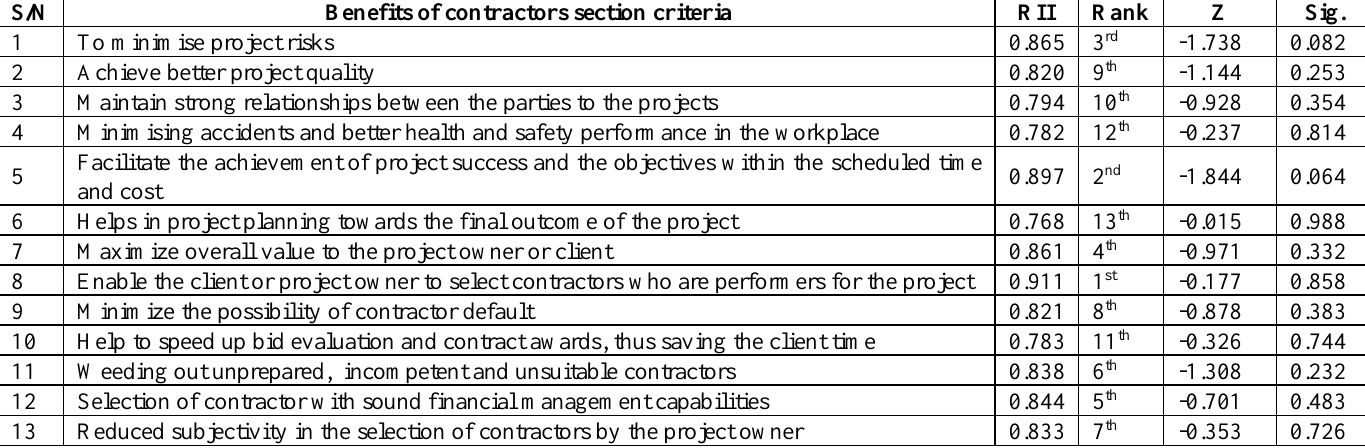
Table 7: Benefits of contractors section criteria in civil engineering projects.